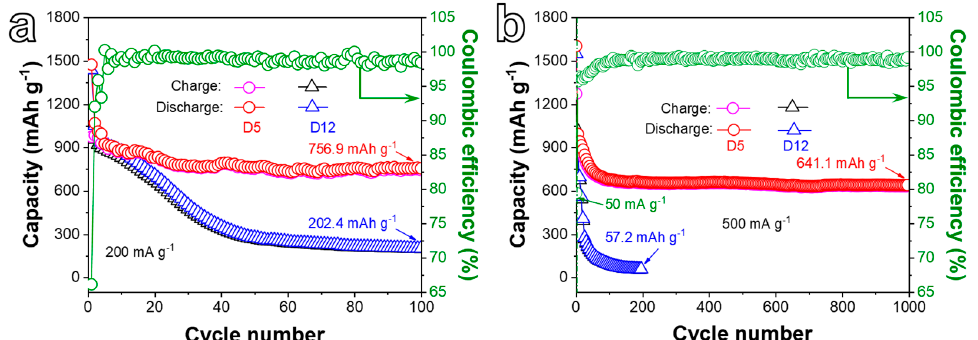
Figure 6. ( a ) Cycling performances of D5 and D12 electrodes at a CD of 200 mA g − 1 for 100 cycles. ( b ) Cycling performances of D5 and D12 electrodes at 500 mA g − 1 for 1000 cycles.